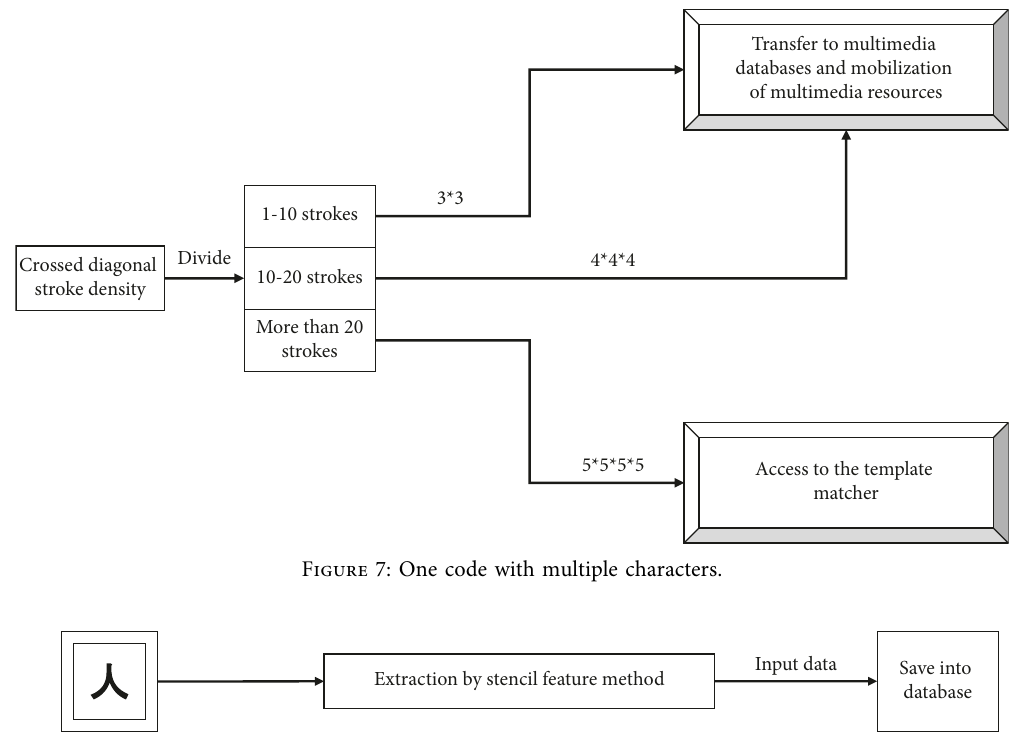
Figure 8: Grey-scale template learning